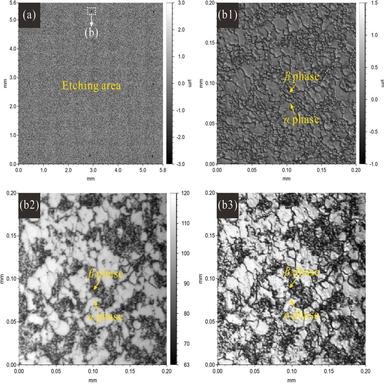
Scanning and locating of etching region in TC4 titanium alloy and corresponding surface microstructure observation: (a) surface profile of etching area after the filtering process; (b) location of etching area by automatic microhardness tester, (b1) white light interference 3D morphology of micro-region on etching surface, (b2) grayscale of light intensity of micro-region on etching surface, (b3) superposition of white light interference 3D morphology and grayscale of light intensity on etching surface micr